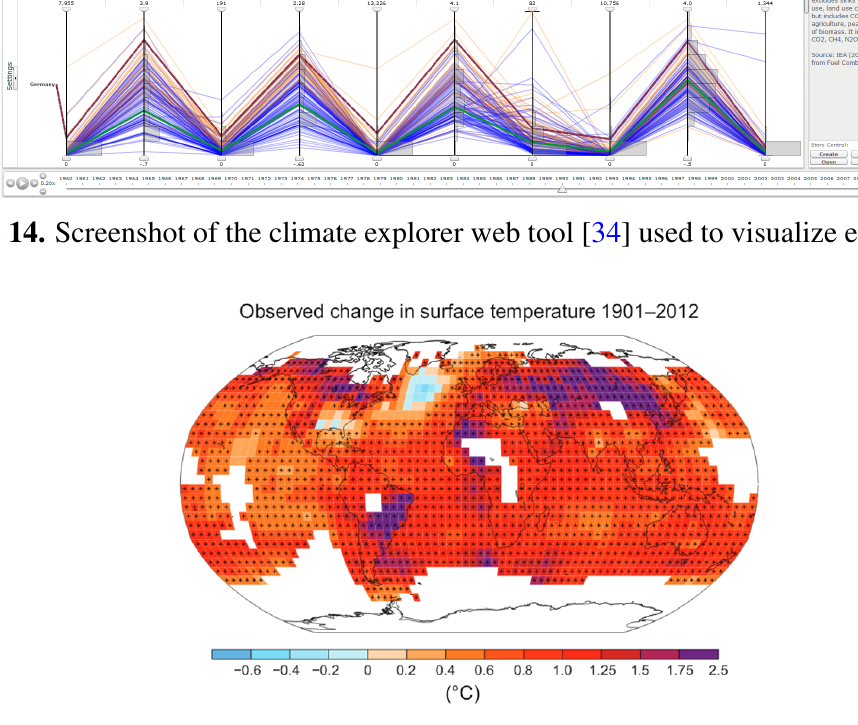
Figure 15. Map showing changes in surface temperature (IPCC AR5 WG1 Figure SPM.1b p.6